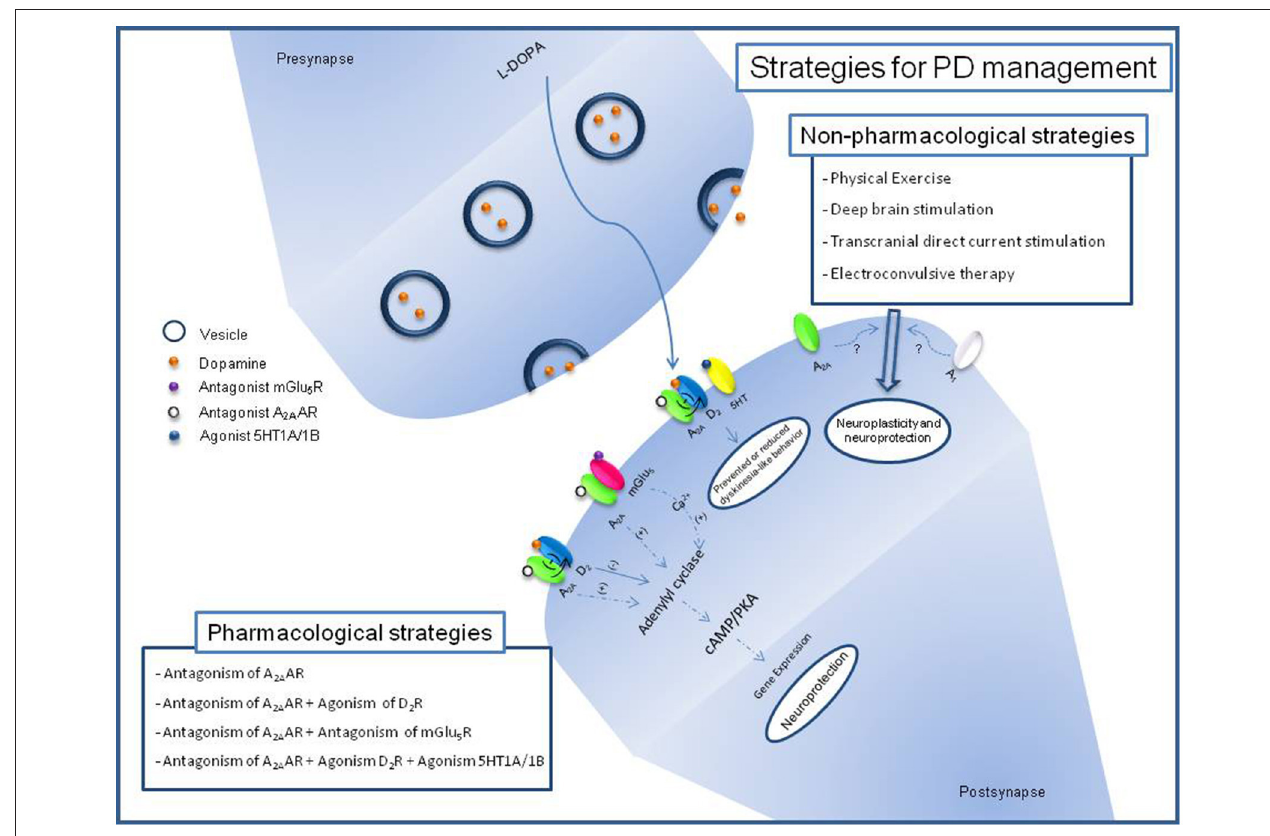
FIGURE 1 | Schematic description of pharmacological and non-pharmacological strategies for PD management and its relation with adenosinergic signaling. Block of A 2A AR by antagonist induces reduction of positive effects over Adenylyl cyclase and negative effects over D2R signaling. Block of mGlu 5 R reduces its positive effects over Adenilyl cyclase through release of Ca 2 + . Recent studies with non-phamacological strategies for PD have been related it with adenosine receptors